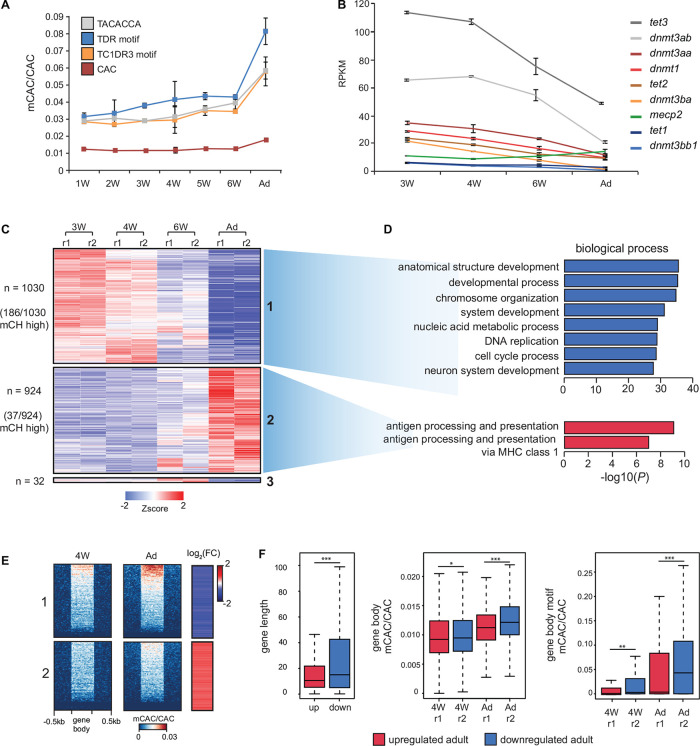
mCH accumulates in the developing nervous system. (A) mCAC/CAC levels at all CAC trinucleotides and top methylated CAC motifs in larval (W = weeks old) and adult (Ad) brains, as determined by RRBS. Data is represented as the average of two biological replicates with error bars (standard deviation). (B) RPKM (reads per kilobase per million) values of dnmt, tet, and mecp2 transcripts in larval and adult brains determined by RNA-seq. Data is represented as the average of two biological replicates with error bars (standard deviation). (C) Transcription intensities of a merged collection of differentially expressed genes called between all pairwise comparisons of larval and adult stages (r1—replicate 1, r2 = replicate 2). (D) Gene ontology enrichment of differentially expressed genes in larval and adult brains. (E) mCAC levels and relative RNA expression levels (log2 fold change 4W/Ad) at differentially expressed genes. (F) Comparisons of gene length (left), gene body mCAC/CAC (middle), and gene body mCAC/CAC at top methylated motifs (right) in genes that are either upregulated or downregulated in the adult brain (Wilcoxon test, ∗P < 0.05, ∗∗P < 0.01, ∗∗∗P < 0.001).